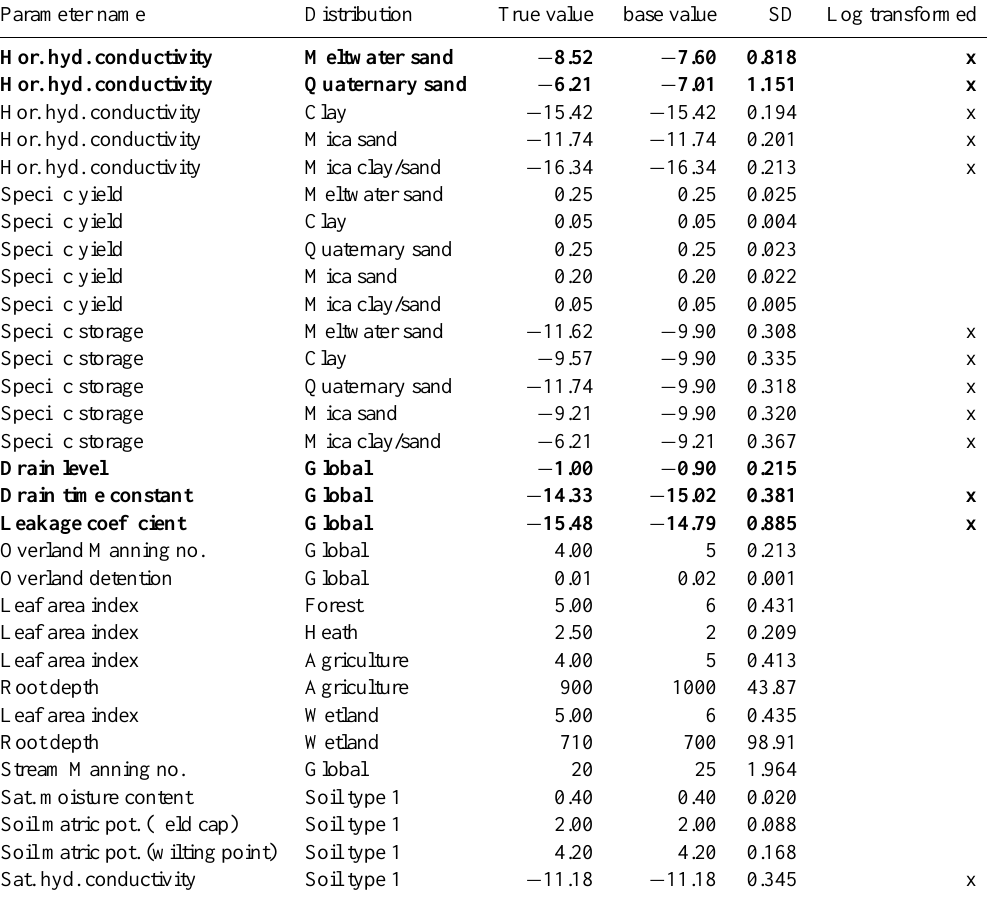
Table 2. List of parameters perturbed to create the true model and to add noise to the filter ensemble. Parameters in bold are included in the parameter estimation. Parameters with very low sensitivity were omitted. Parameters are perturbed using Gaussian noise with standard deviation (SD) shown in the